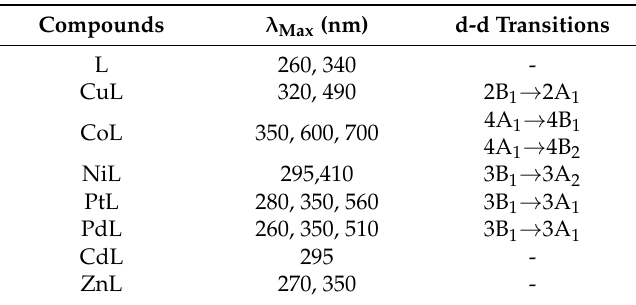
Table 4. Electronic spectra data of ligand (L) and its metal complexes.